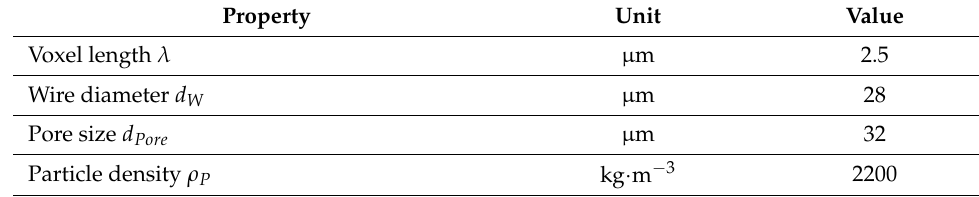
Table 3. Model parameters of the woven wire cloth filter medium, particles and fluid. Property